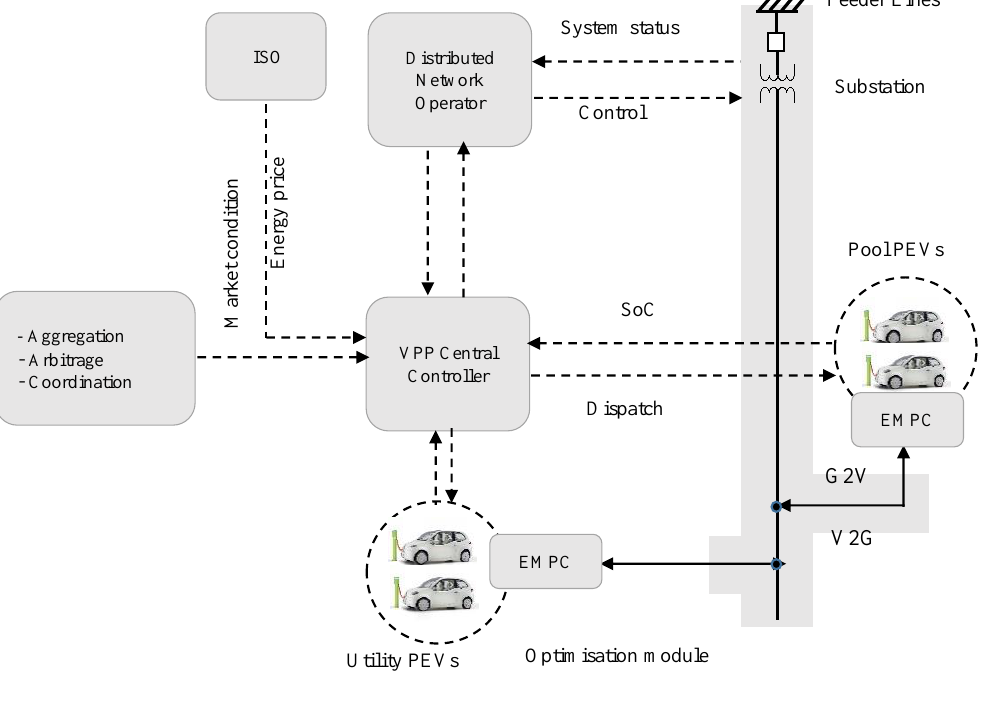
Figure 1. A model of bi-directional coordination of PEVs and their interactions with the